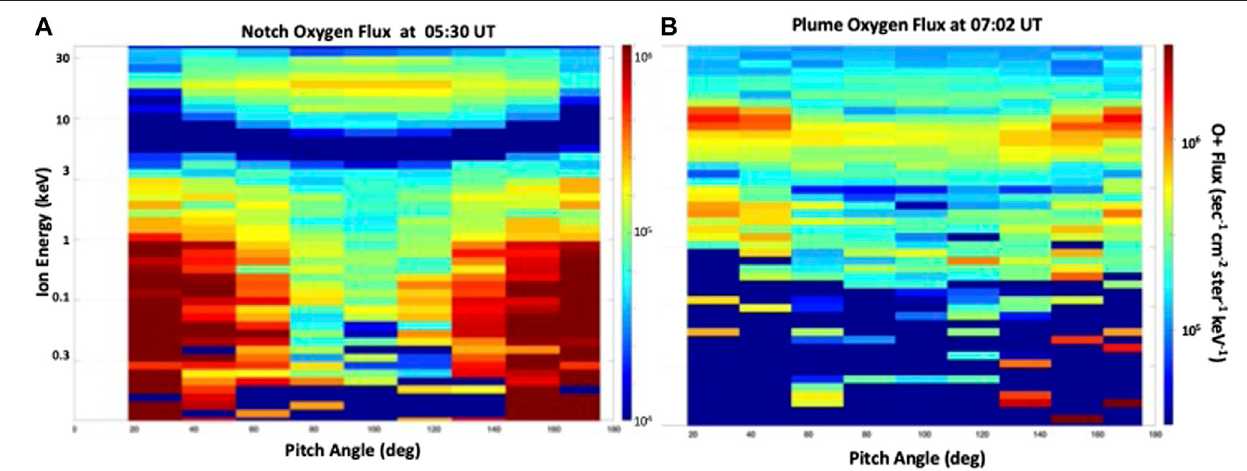
FIGURE4| RBSP-AobservedO+pitch angle spectraareshown forthefullrange ofHOPE ionenergieson October15, 2013forthetimes indicatedin Figure3A . (A) In the region between the morning-side plasmapause and the plume (05:30 UT in Figure 3A ), notch O+ at energies < 3 keV tend toward bi-directional fi eld alignement, while ring current O+( ∼ 10 keV) exhibit apancake PAD. (B) On plume fi eld lines (07:02 UT), O+ at ring current energies around 10 keV isbi-directionally fi eld aligned while the lower energy O+ ( < 5 keV) largely is